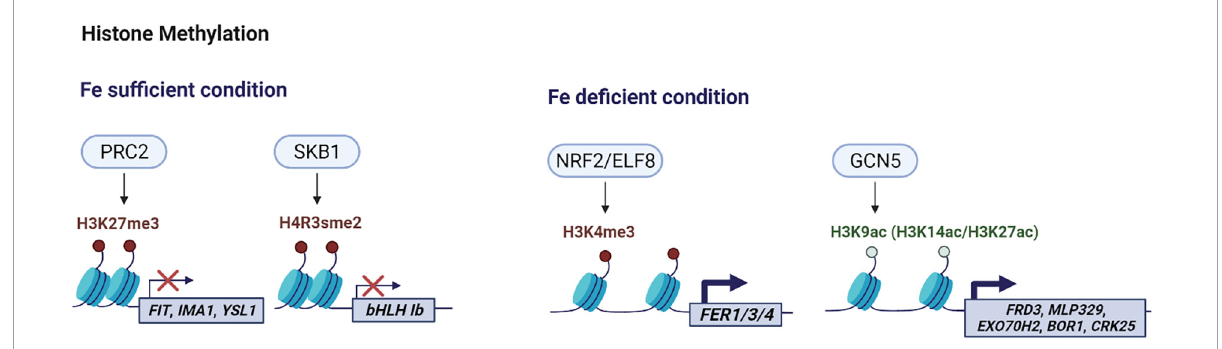
FIGURE1 Schematic overview of histone modifications involved in iron homeostasis in Arabidopsis. Under iron sufficiency, PRC2-mediated H3K27me3 induces chromatin condensation in Arabidopsis, resulting in gene silencing of the target genes such as AtFIT , AtIMA1 and AtYSL1 . AtSKB1-induced H4R3sme2 also suppresses AtbHLH1b transcripts when iron is sufficient. Under iron deficiency, AtNRF2/ELF8 catalyzes the trimethylation of H3K4 generating H3K4me3, and AtGCN5 acetylates H3K9 producing H3K9ac and facilitates the generation of H3K14ac and H3K27ac to activate corresponding target genes. The color scheme denotes methylation (red), acetylation (light green), histone (light blue). This figure was created with BioRender.com.